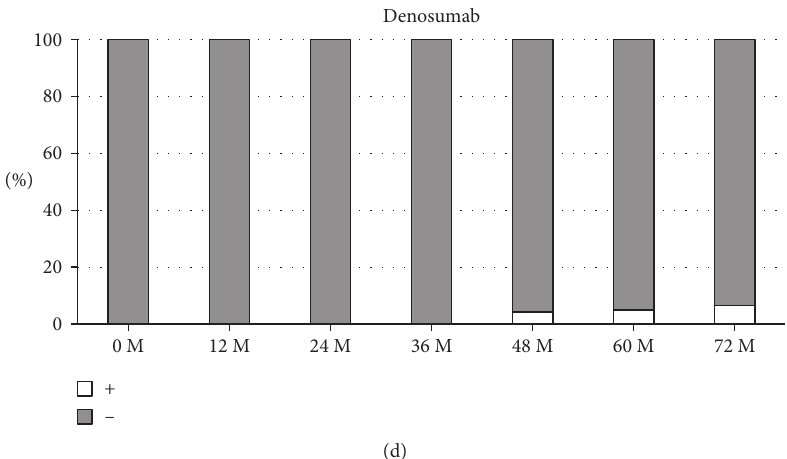
Figure 4: Percentage bar graph of patients treated with calcimimetic (a), vitamin D (b), bisphosphonate (c), and denosumab